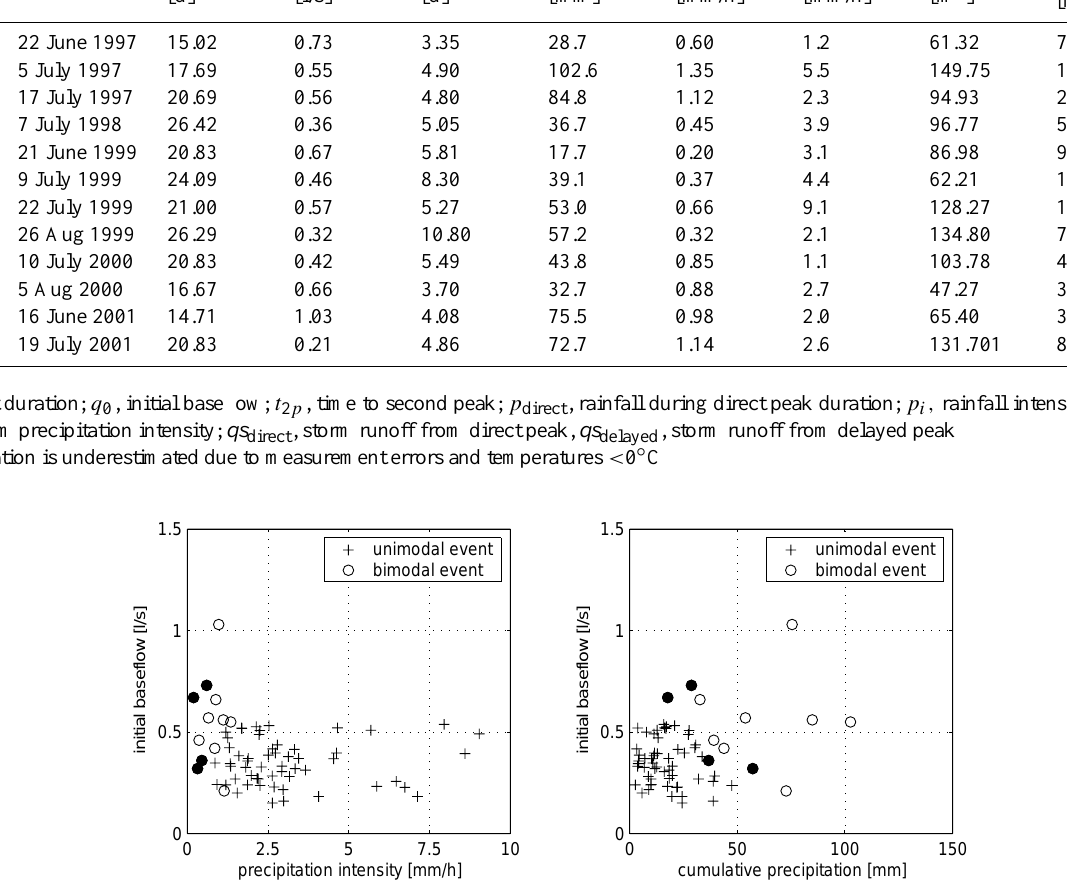
Fig. 6. Hydrological characteristics of the two event types (unimodal and bimodal) of the micro-scale catchment, stream gauge Limberg. Filled circles indicate bimodal events with underestimated precipitation due to measurement